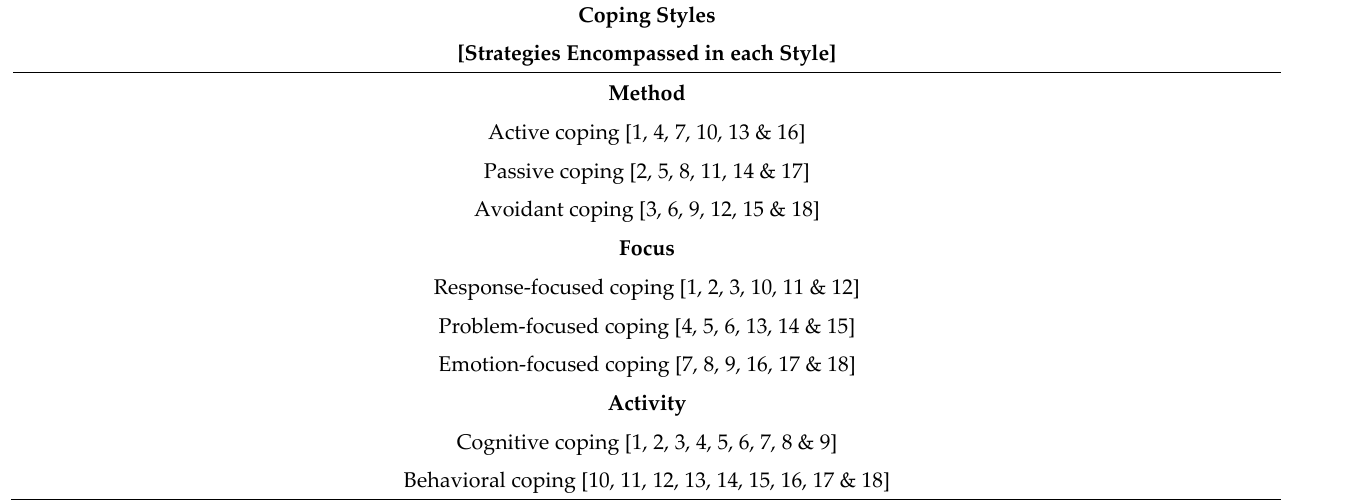
Figure 1. Coping strategies and styles.